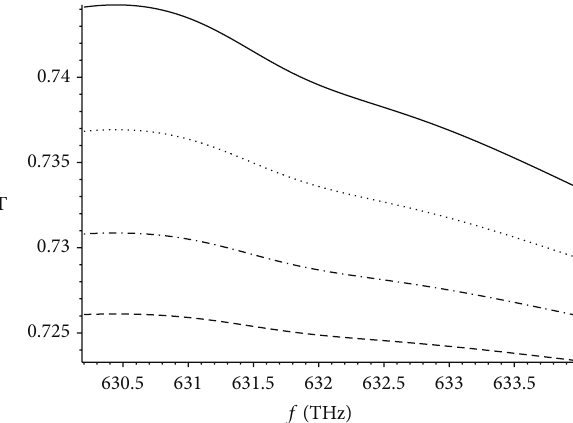
Figure 5: The power confinement factor versus the operating frequency for different dielectric core thicknesses. The core thicknesses are 30 nm (dashed), 40nm (dot-dashed), 50 nm (dotted), and 60 nm (solid).